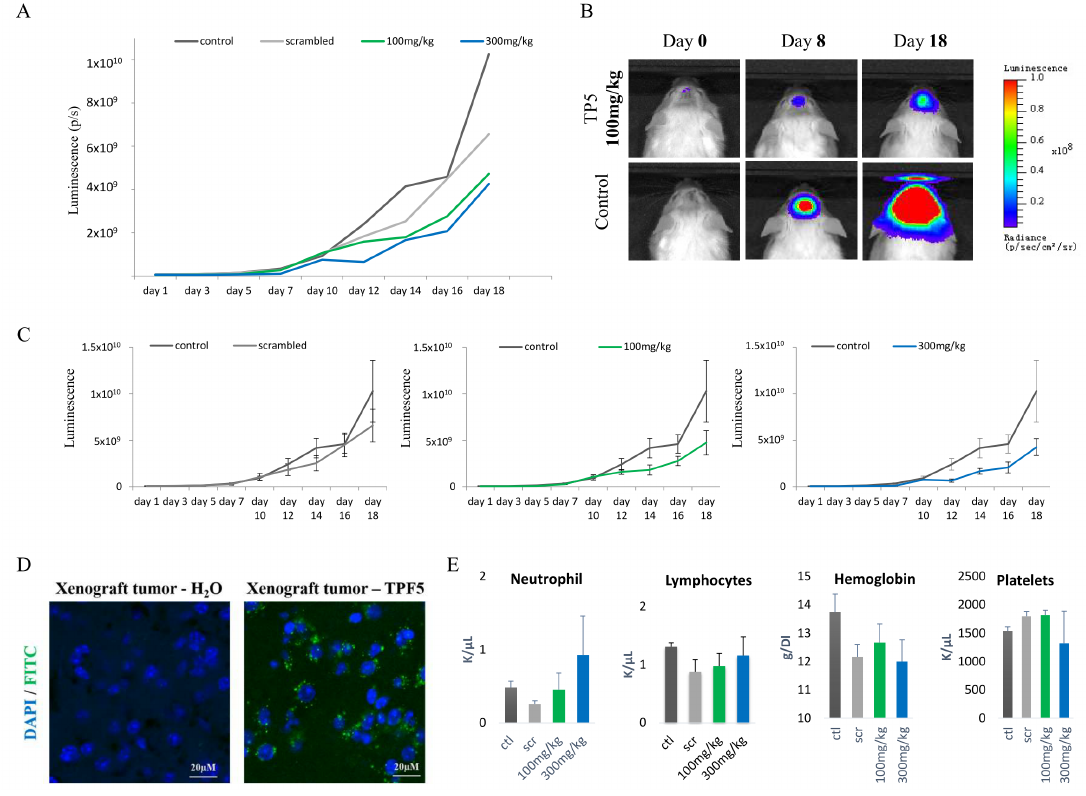
Figure 5. Cont . Figure 5.